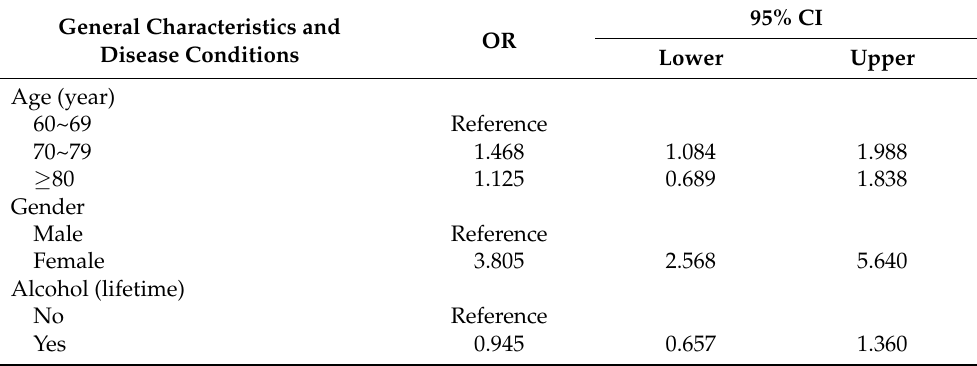
Table 2. Odds ratios (ORs) of major depressive disorder (MDD) according to general characteristics and disease